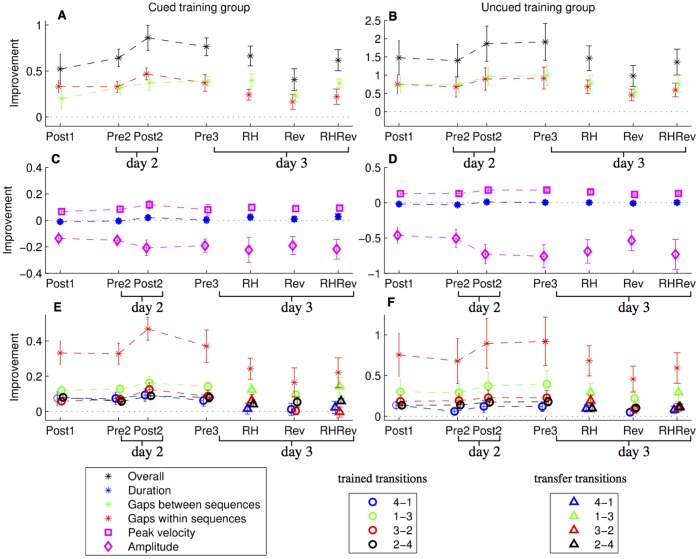
Mean improvement (relative to the first test session).Pre and Post refer to the tests before and after training. RH, Rev and RH Rev refer to the transfer conditions, right hand, reversed and right hand reversed respectively. The left column shows the Cued group, and the right column the Uncued group. The first row shows that the net improvement (in black) is primarily due to reducing the gaps within sequences (in red) and between sequences (in green). While the overall change in duration had a negligible effect, the decomposition of the duration in the second row into the contributions of peak velocity (square) and amplitude (diamond) shows that there were changes in the way the movements were made (faster movements, but with larger amplitudes). In the third row, the gaps within a movement are further decomposed into the gaps between the individual finger movements (circles), which sum to the total improvement due to reducing the gaps (in red stars). In both groups, the 1–3 transition was responsible for the greatest amount of improvement. The triangles indicate the gaps in the transfer conditions. We note that the scales are not equal across the groups.